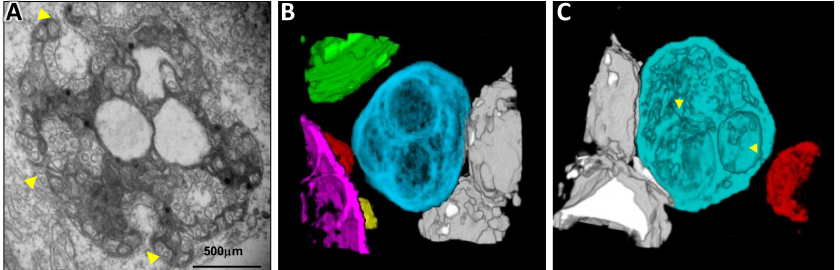
Figure 5. Transmission electron microscopy (TEM) analysis and 3D reconstruction of melon necrotic spot virus (MNSV)- altered mitochondria by focused ion beam/field emission scanning electron microscopy (FIB-FESEM). ( A ) TEM image of the samples used for FIB/FESEM showing the altered mitochondria ultrastructure with big dilations inside, and numerous vesicles in the external membrane and inside the organelle (arrowheads). ( B ) 3D model of the complete altered mitochondria (blue) next to other organelles such as chloroplasts (green), lipid bodies (grey) and other modified mitochondria (red, yellow and purple). ( C ) 3D reconstruction of the infected mitochondria using a partial series of FIB/FESEM images showing the presence of pores connecting the different internal dilations, as well as the lumen of the dilations to the cytoplasm. The connection pores are indicated with yellow arrowheads. This figure is adapted with permission from